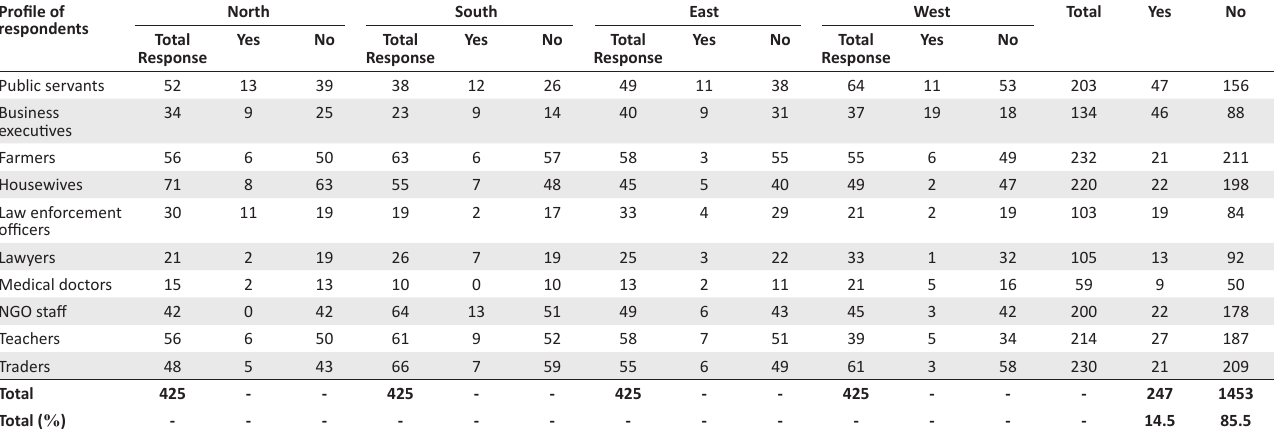
TABLE 5: Leadership interest in shared governance and conflict resolution. Profile of